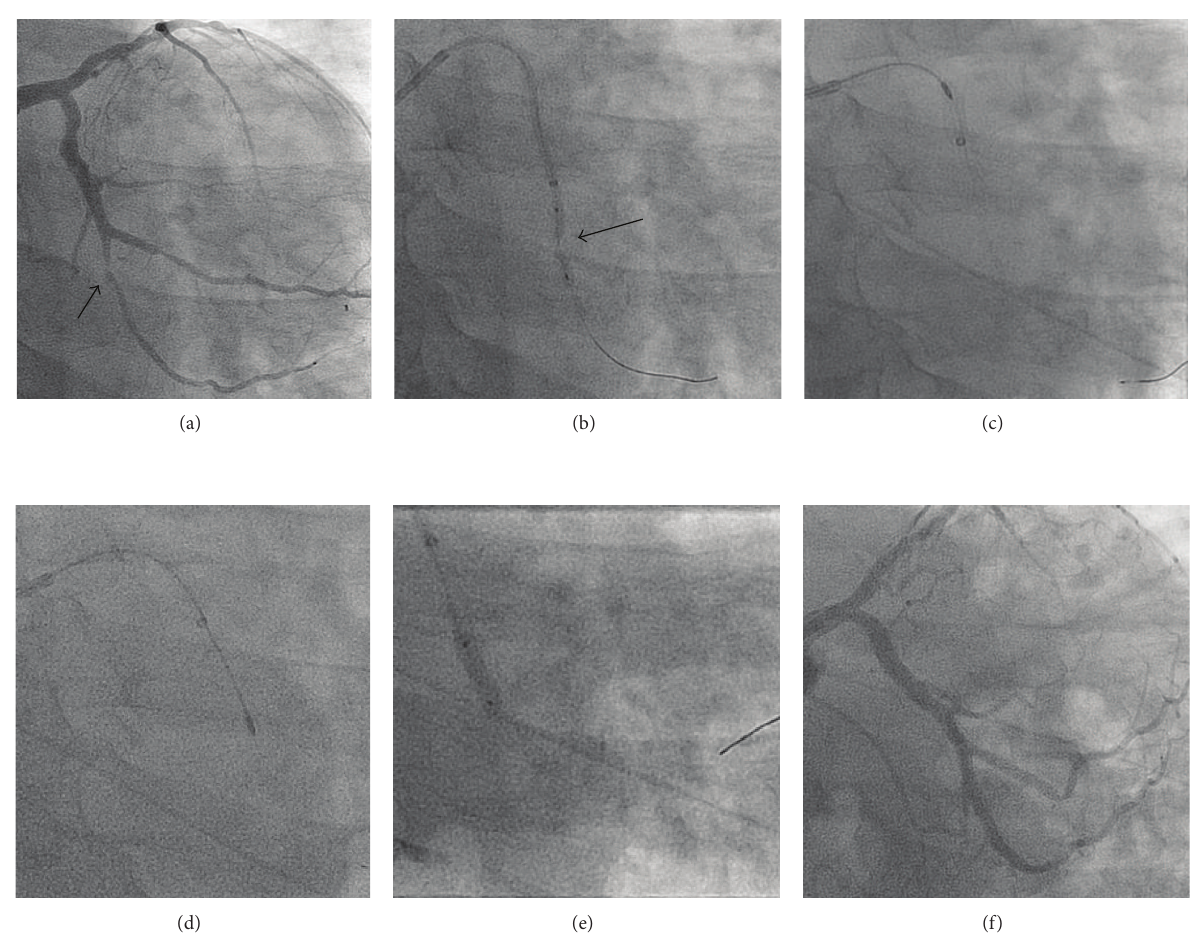
Figure 1: Rotablation of the 2nd obtuse marginal branch of the left circumflex, assisted with the insertion of a 7Fr. GuideLiner catheter. (a) Severe calcific lesion within OM2 branch (arrow). (b) Resistant lesion within OM2 to noncompliant balloon expansion. (c) Advancement of a 1.25 mm rotablation burr through the GuideLiner. (d) Multiple passes of 1.25 mm burr into the lesion. (e) Successful stent deployment within the lesion. (f) Final results after stent deployment in the OM1 and